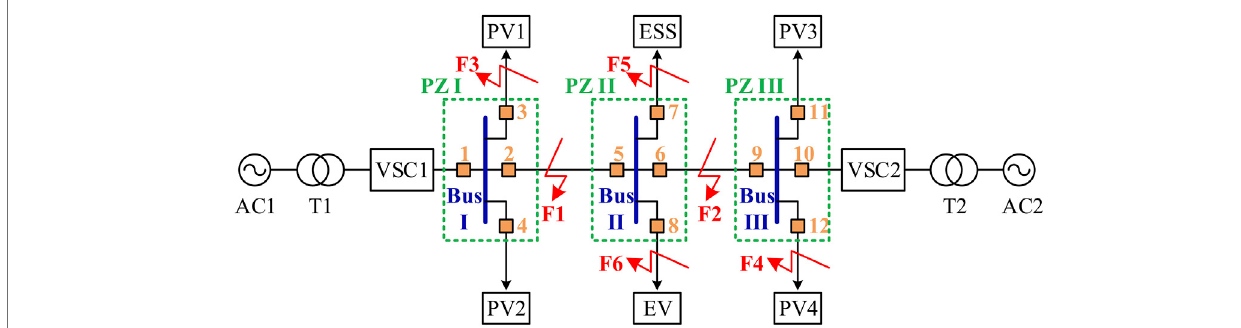
FIGURE 1 | Typical structure of a DC micro-energy system.